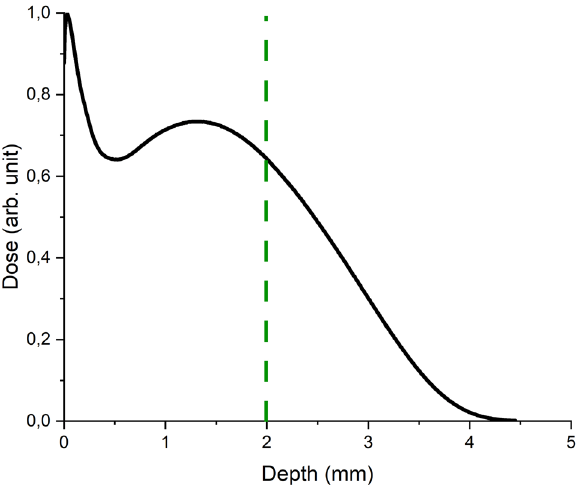
Figure 2. Depth dose distribution in a water layer 5 mm thick during 1 MeV electron treatment from one side. The dashed line is the average thickness of the turkey